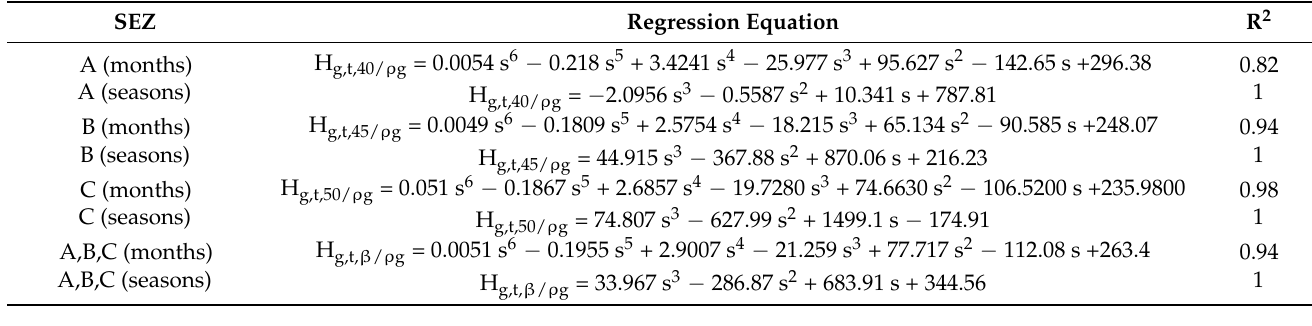
Table 3. Regression equations for the best-fit curves to the monthly/seasonal mean H g,t, β / ρ g sums averaged over all respective sites in the period 2005–2016, together with their R 2 values; s is either month in the range 1–12 or season in the range 1–4 (1 = spring, 2 = summer, 3 = autumn, 4 = winter).